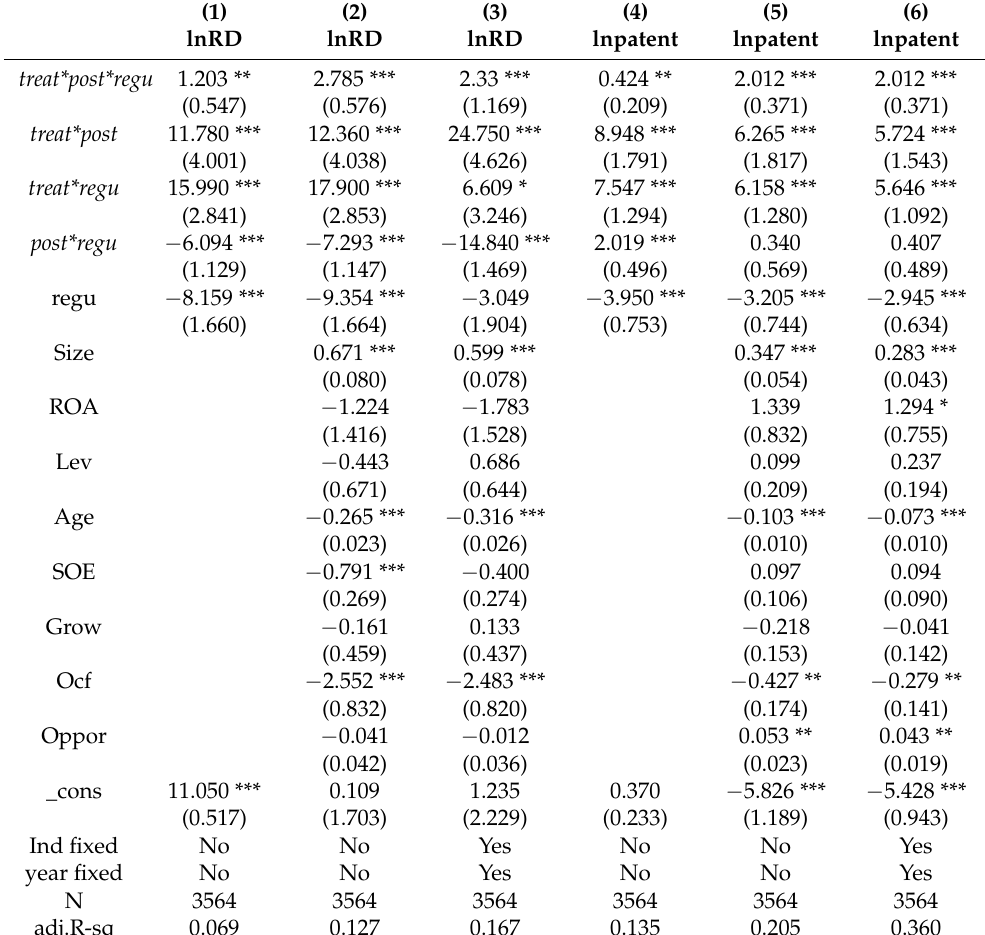
Table 7. The moderating effect of strength of environmental regulations in the carbon